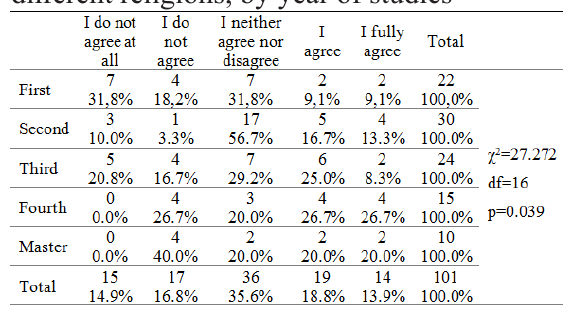
Table 5. Differences in attitudes to the